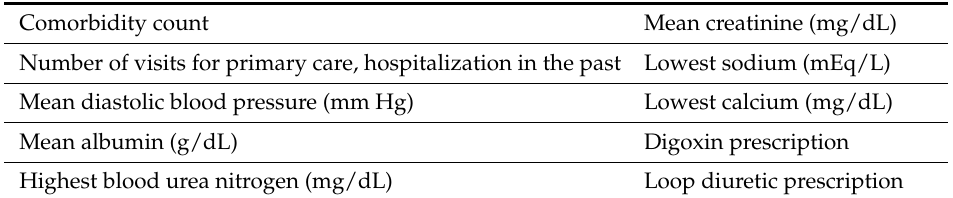
Table 4. Technical questionnaires, which can be completed by users by consulting their health service provider. This information would be required to fully access the centralized health service network server.